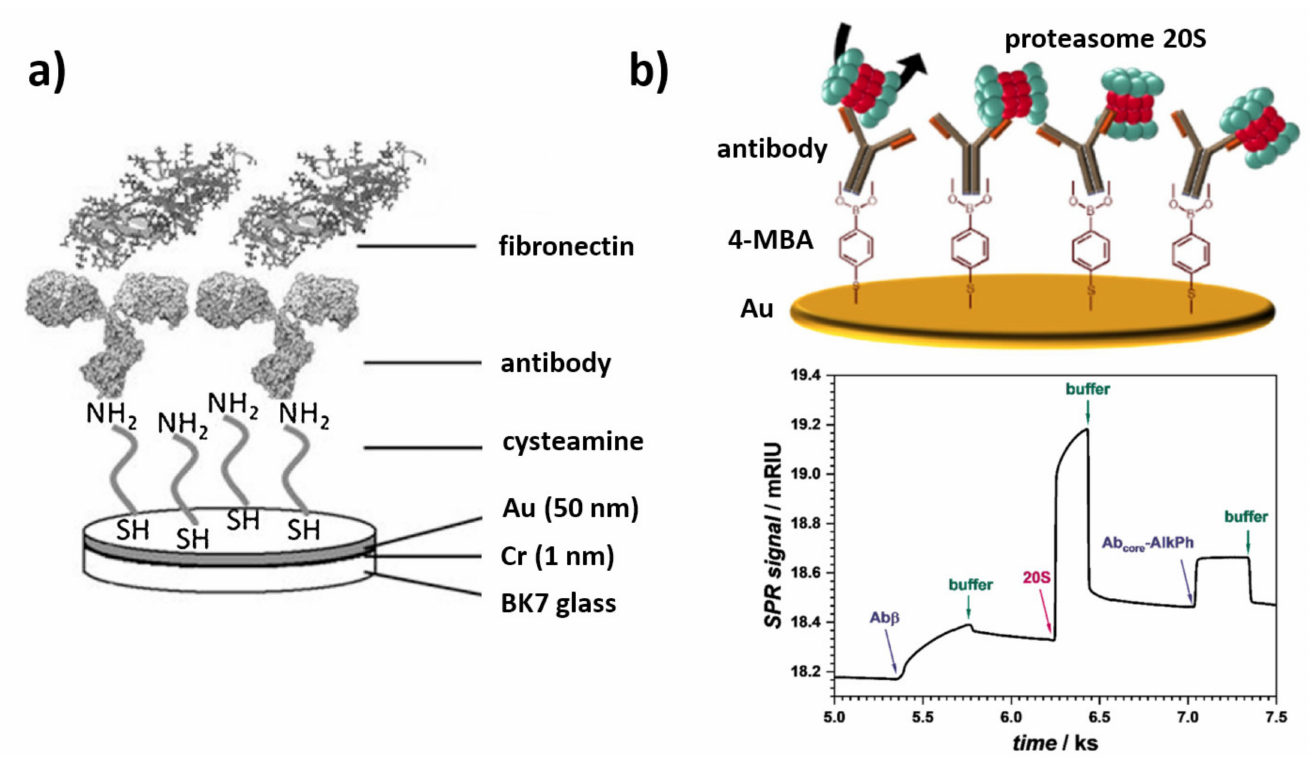
Figure 3. ( a ) The architecture of the oligopeptide SAM-based SPR immunosensor, ( b ) the mechanism of antibody immobi- lization through the interaction of carbohydrate residue with boronic acid SAM. Adapted with permission from Sankiewicz et al. [70] (Copyright © (2018) Elsevier) and Barsan et al. [71] (under the terms and conditions of the Creative Commons CC BY